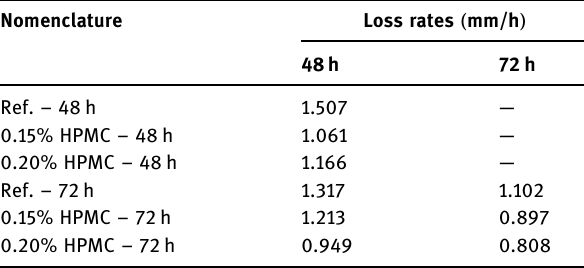
Table 8: Consistency index loss rates over